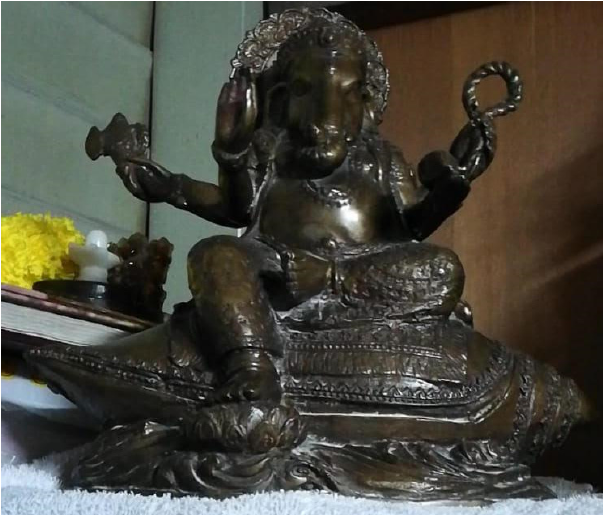
Figure 4. A personal statute of Ms. O that she received as a prize at the Janam Ashtami event. Photo credit: Ms. O (2015). Images used with permission.